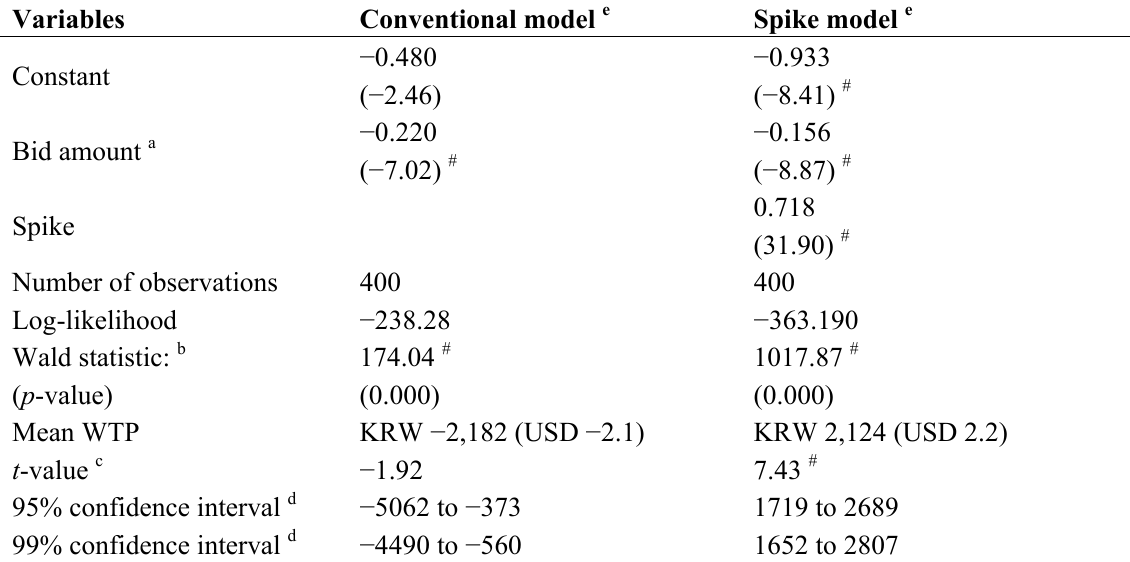
Table 2. Estimation results of the conventional and spike